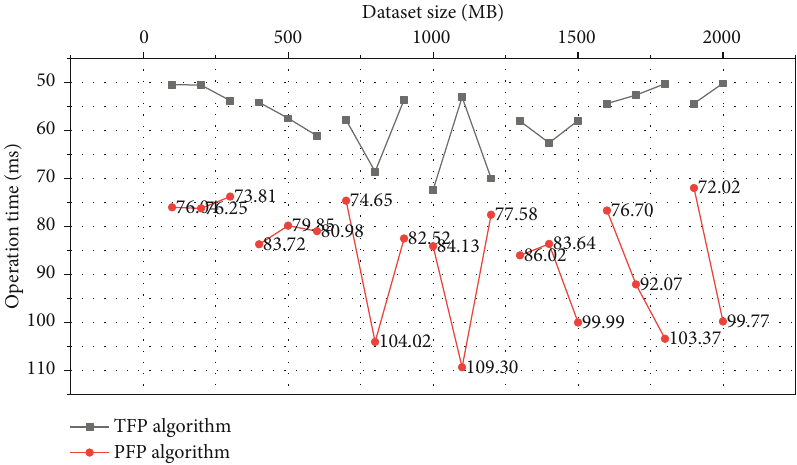
Figure 4: Comparison of algorithm running time with di ff erent data set